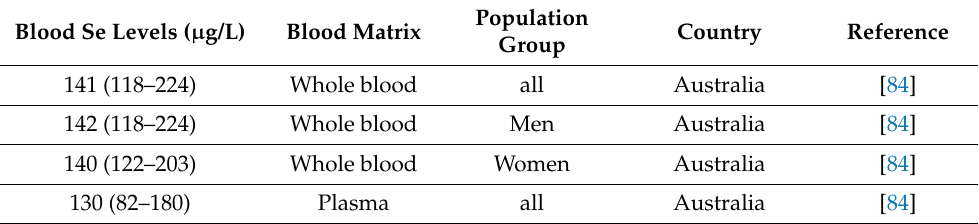
Table 5. Selenium levels in blood from selected